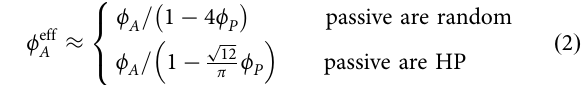
Fig. 4 A swarm of active swimmers cooperatively corrals passive particles. a a ternary phase diagram of active ( ϕ A ) passive ( ϕ P ) and the surrounding water bath ( ϕ W ) depicts the resulting dynamics of a mixture of passive particles and active swimmers, given their initial area fraction. Green triangles show that at low overall-particle area fraction (large ϕ W ), the active swimmers quickly disperse. Red circles show a region where the active particles crowd once activated and form a persistent dense phase. Between the red and the green regions, 1 (cid:3) 4 ϕ P < ϕ A = ϕ (cid:4) < 1 (cid:3) where orange hexagons signify experiments where active particles spontaneously corral the passive particles ( ϕ * is denoted by a star). Red and orange curves are theoretical predictions for the onset of the corralling state extrapolated for the small ϕ P limit. Thumbnails show snapshots from corresponding points on the diagram (orange and cyan label active and passive particles, respectively). Blue region indicates an overall-particle area fraction greater than 0.91 (hexagonal packing). b – d snapshots taken at time 0 min ( b ) 5 min ( c ), and 30 min ( d ) show the global dynamics of the active particles (orange) as they corall the passive particles (cyan) (see Supplementary Video 6). Insets are the structure factor, S towards hexagonal order in their packed arrangement. e the pair correlation function has peaks at 1, 2, 3, and 4 diameter, with 1 (cid:3) indicative of ordered hexagonal packing. f snapshots at 20 seconds intervals show the corralling process which proceeds through entrainment events, where an active particle (orange) deposits a passive particle (cyan) at the dense region. After deposition, the active particle leaves (see Supplementary Video 2). Scale bars: b – d 30 μ m; f : 10 μ